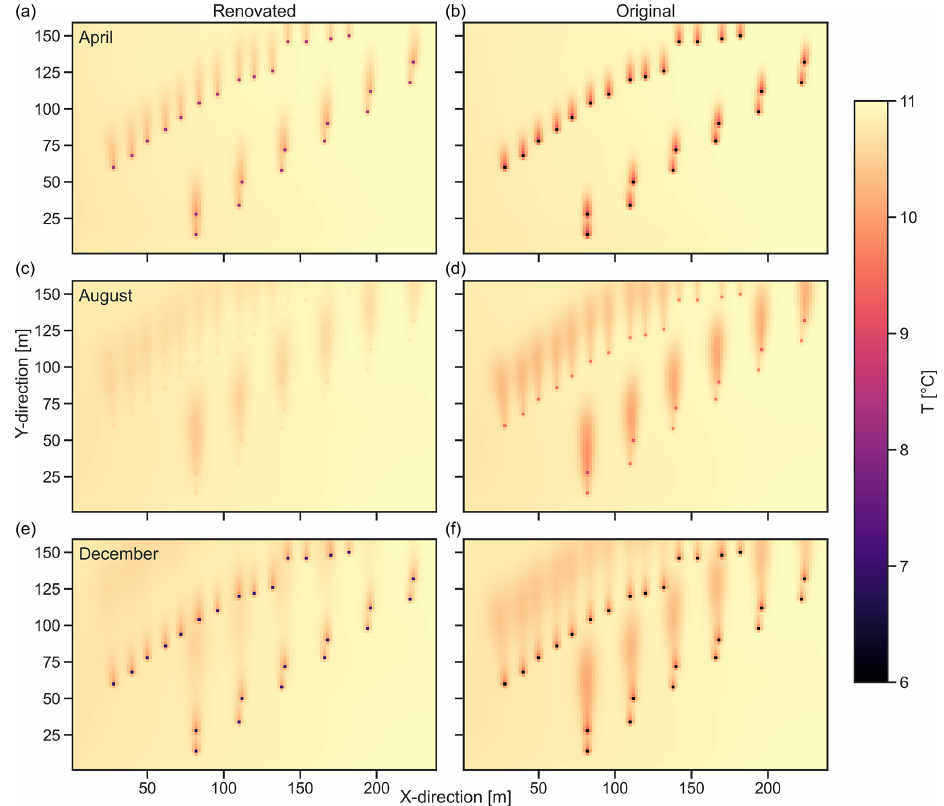
Figure 4. Map views of temperature slices at 50m depth below surface. (a, c, e) Temperature slices for the vGSHP field assuming renovated buildings. (b, d, f) Temperature slices assuming original building structure. Table 2. Geological units and ascribed petrophysical properties used for the vGSHP Models. The properties are inherited from the calibrated regional heat and fluid flow